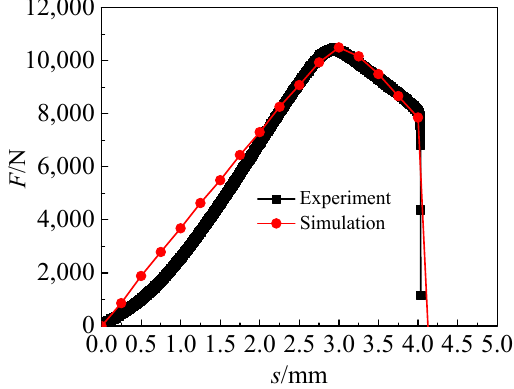
Figure 3. Comparison of notch uniaxial tensile test results and simulated results.